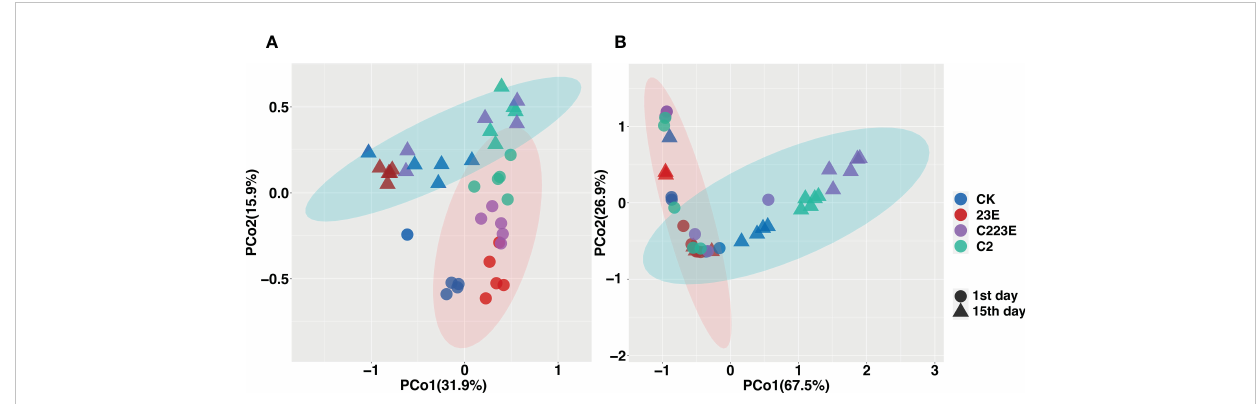
FIGURE 3 Distribution patterns of different treatment of phyllosphere bacteria-associated microbial communities. Principal coordinate analysis (PCoA) revealed the beta diversities of different treatment of phyllosphere epiphytes (A) and endophytes (B) bacterial communities. The black circle indicates the fi rst day of inoculation and the black triangle indicates the 15th day post inoculation. CK, Control; C2, Xoo strain alone; 23E, Xoo phages (J2+J3+E);